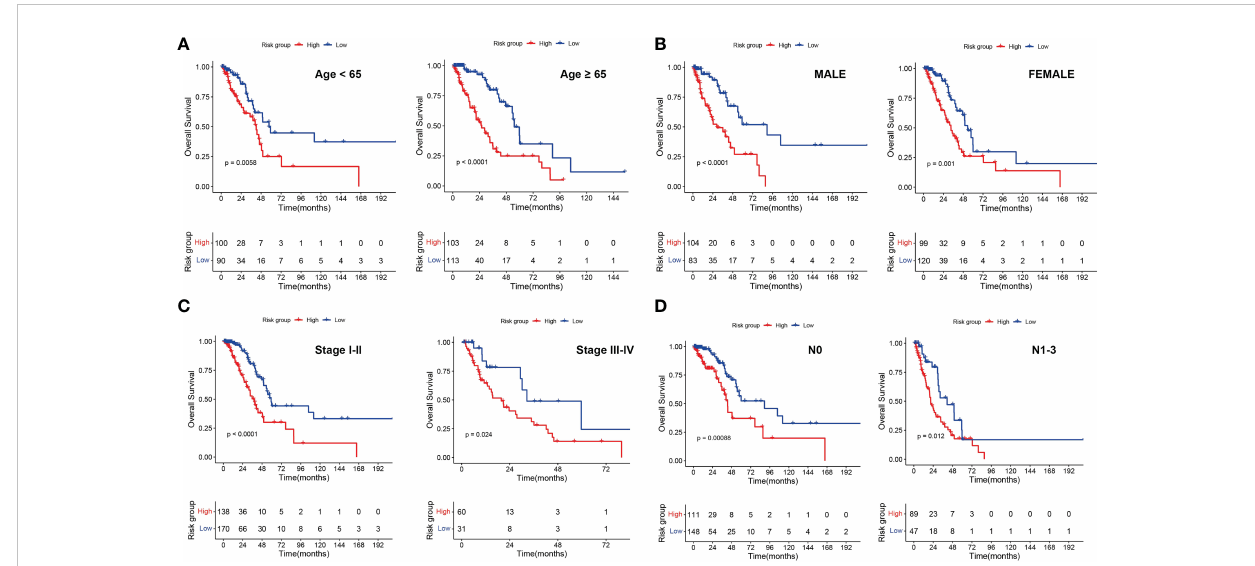
FIGURE 8 Associations of risk scores with clinical characteristics by strati fi cation analyses. Kaplan ‑ Meier survival curves for overall survival of LUAD patients strati fi ed by age (A) , gender (B) , clinical stage (C) and N stage (D) .